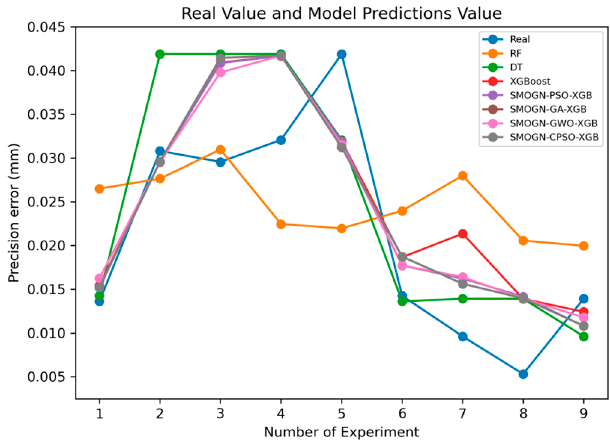
Figure 23. Prediction performance of different models. Table 4. Performance metrics of various